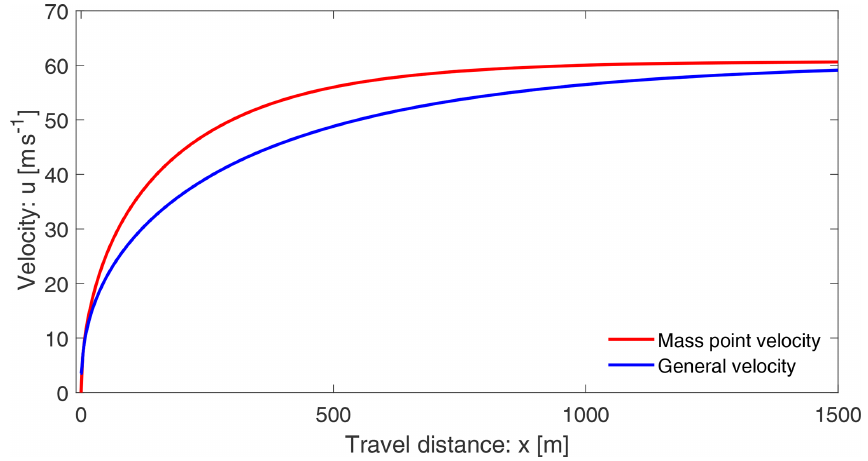
Figure 5. Evolution of the velocity field along the slope as given by Eq. (35) for general velocity against the mass point (or the center of mass) velocity corresponding to Eq. (8).